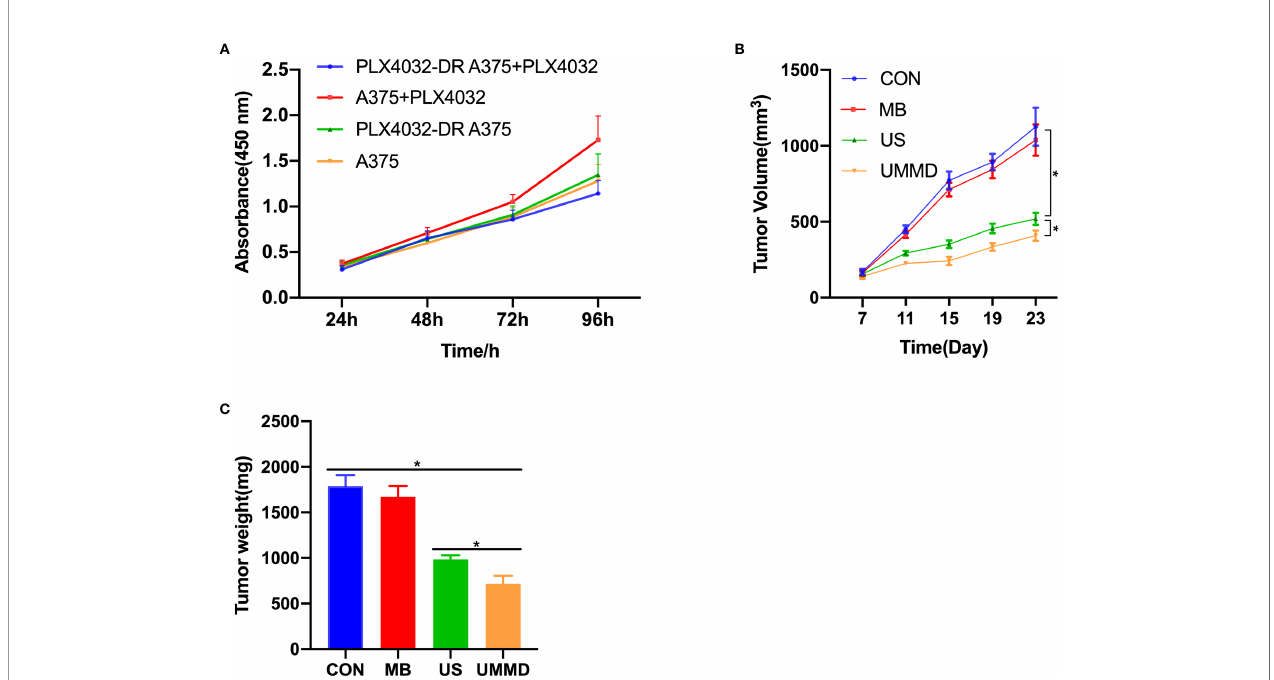
FIGURE 2 | In vivo UMMD treatment inhibited the growth of drug-resistant CMM tumors. (A) CCK-8 assay was used to test the construction of drug-resistant CMM cell lines; (B) Changes in tumor volume; (C) The mice were sacri fi ced after 25 days of perfusion and weighed. * p < 0.05.